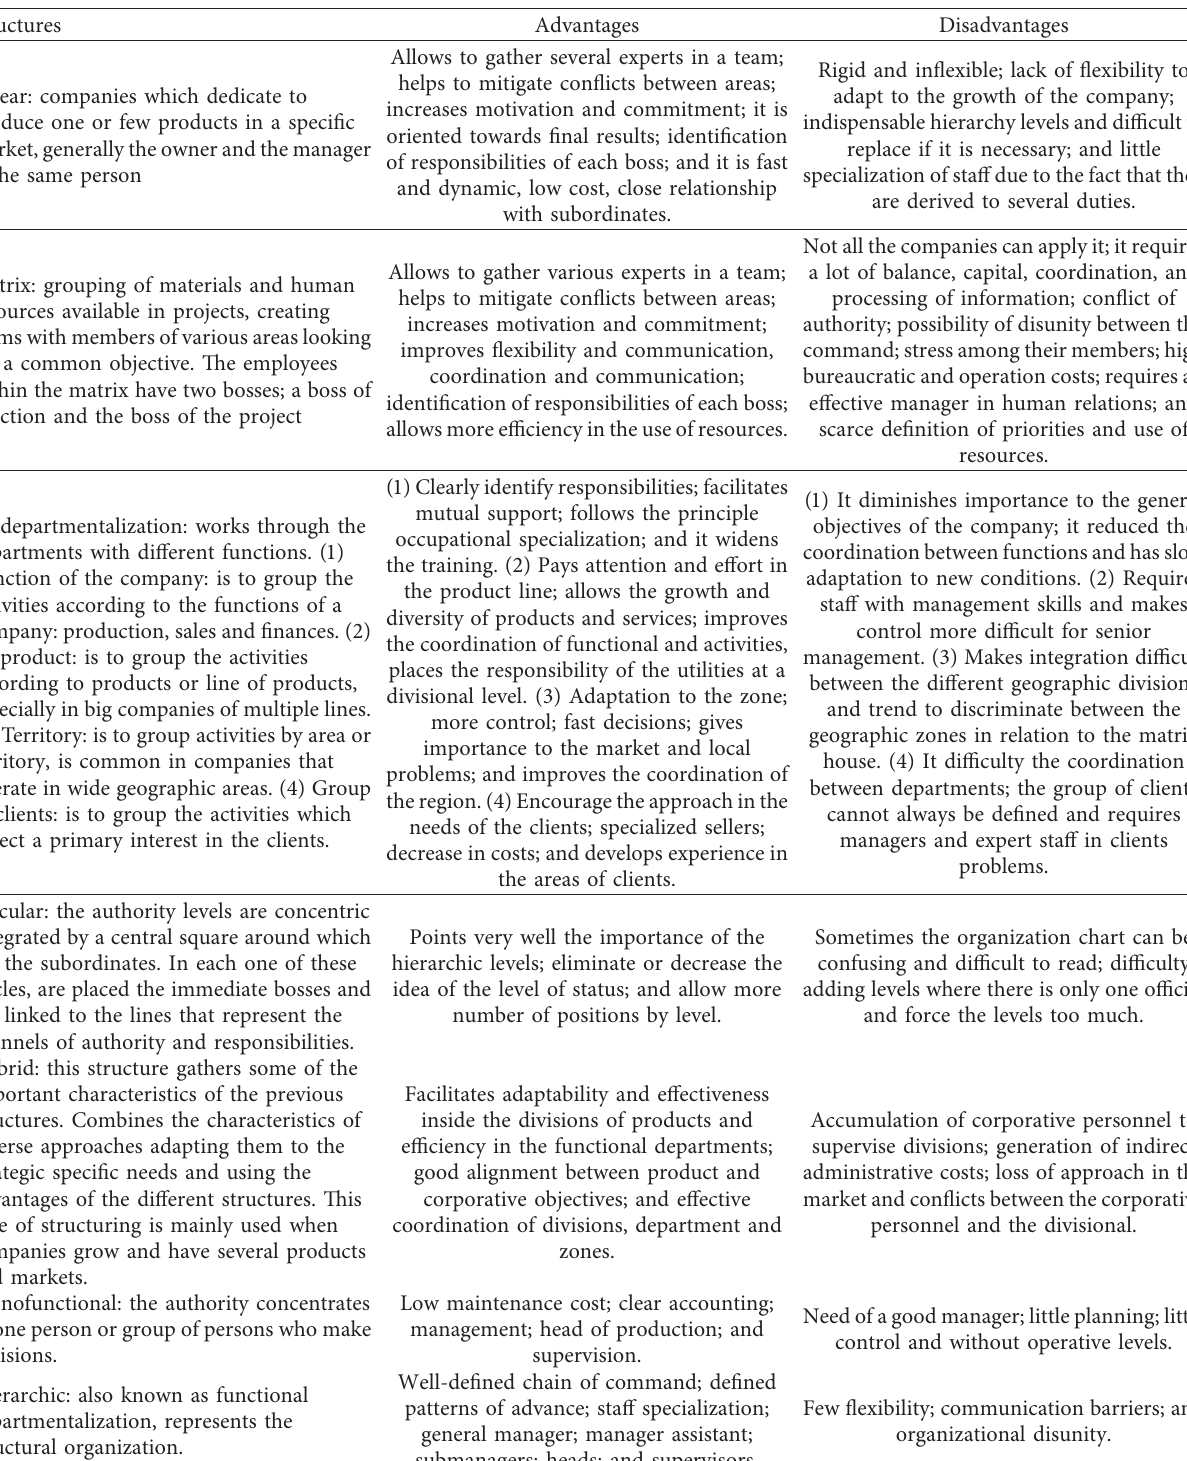
Table 5: Types of organizational